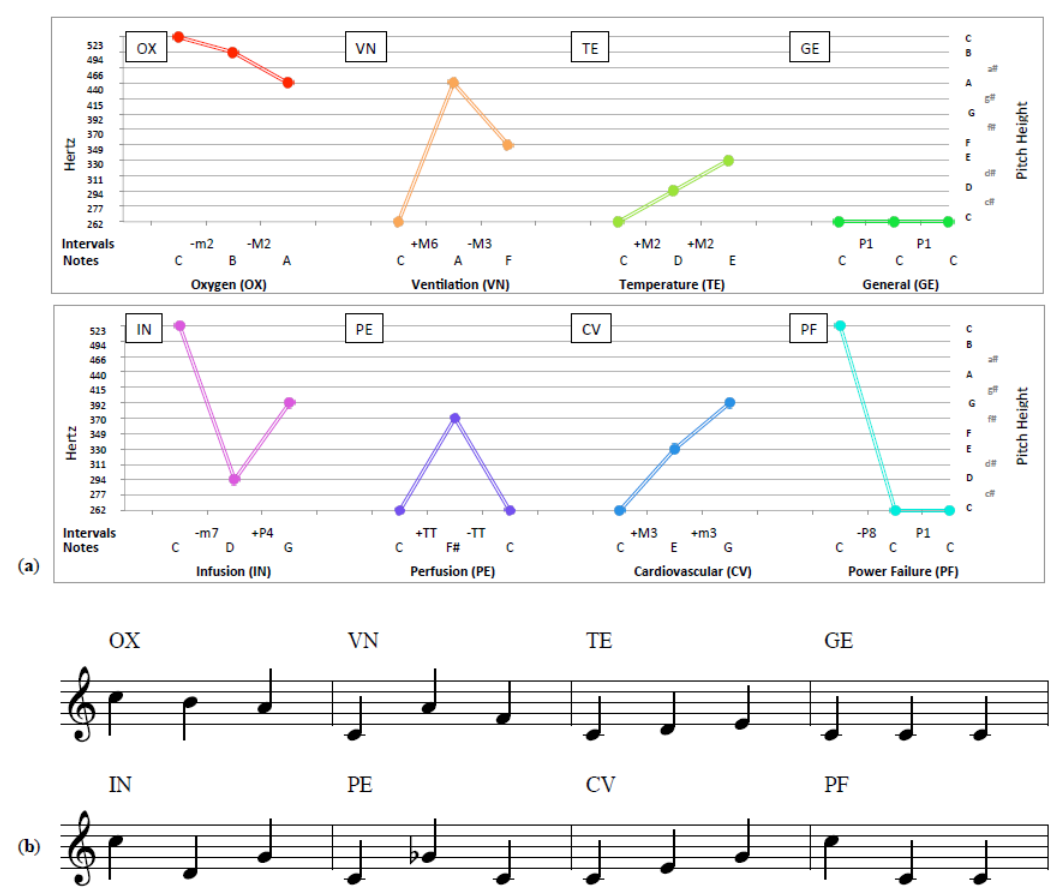
Figure 1. Melodic sequences of the International Electrotechnical Commission 60601-1-8:2006 standard depicted in hertz ( a ) and music notation ( b ). Reprinted from [22].